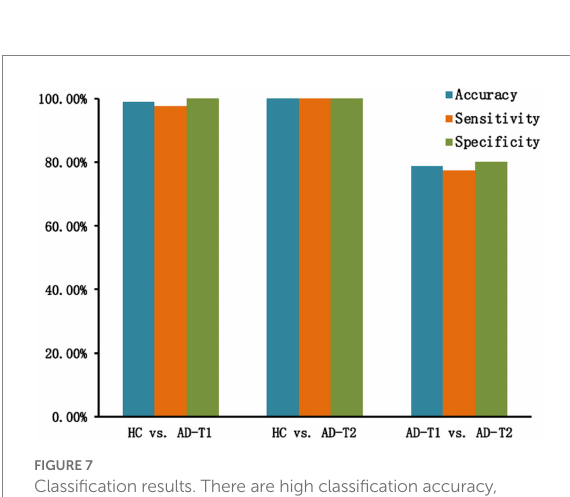
FIGURE 7 Classification results. There are high classification accuracy, sensitivity, and specificity for HC vs. AD-T1 (accuracy of 98.82%, sensitivity of 97.5%, and specificity of 100%), HC vs. AD-T2 (accuracy, sensitivity, and specificity of 100%), and AD-T1 vs. AD-T2 (accuracy of 78.75%, sensitivity of 77.5%, and specificity of